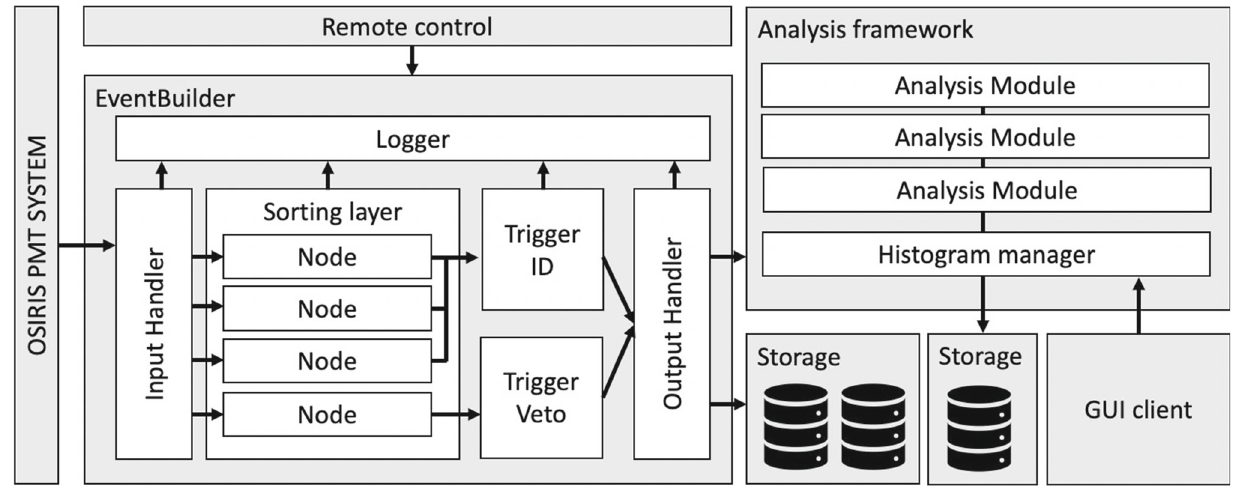
Fig. 13 Schematic overview of the components and data processing in OSIRIS DAQ software